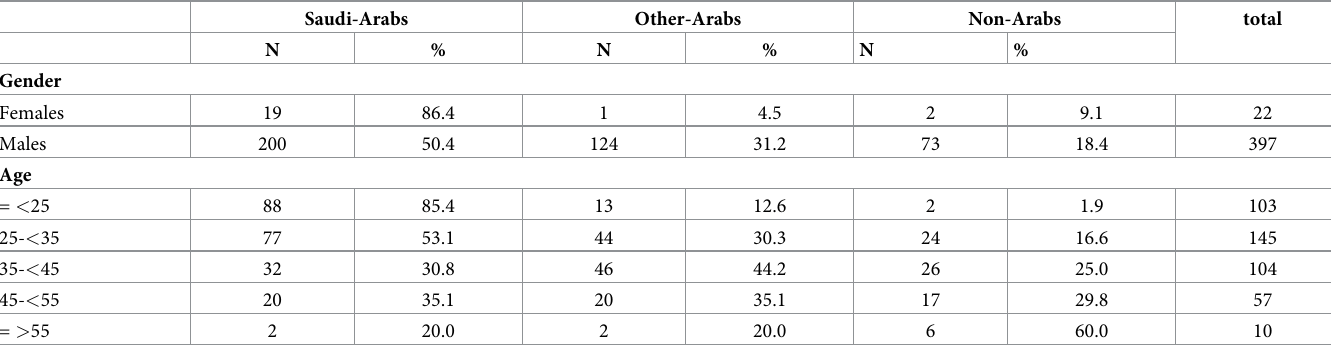
Table 1. Demographic data of the study population.